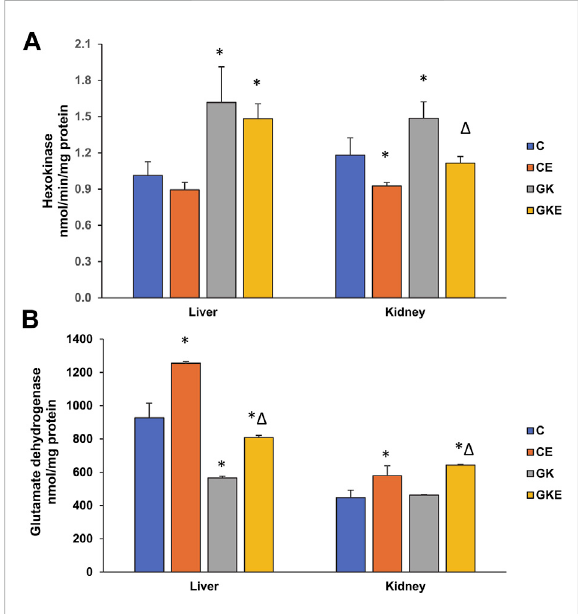
FIGURE 4 Exercise-induced alterations in energy metabolizing enzyme activities in the liver and kidney of control Wistar (C) and diabetic GK(GK)andexercise-trainedcontrol(CE)andGK(GKE)rats( n =5). Hexokinaseactivity (A) wasmeasuredastheNADHgenerated using the hexokinase assay kit and glutamate dehydrogenase (B) was measured using a coupled enzyme assay kit as per the manufacturer ’ s instructions. Histogram valuesare mean ± of three independent experiments and statistical signi fi cance is shown as asterisks, which was fi xed as p < 0.05 (* indicates statistical signi fi cance compared with control Wistar rat tissues while Δ indicates statistical signi fi cance compared with diabetic GK rat